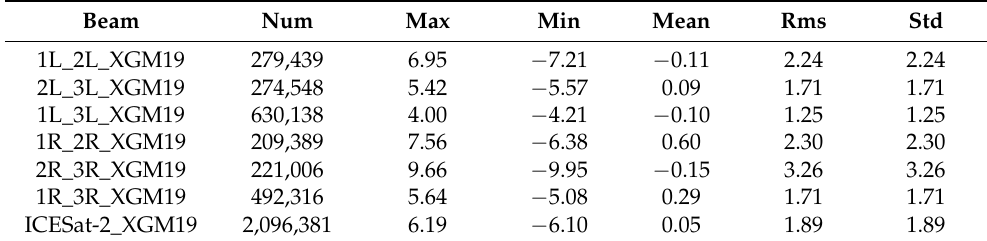
Table 12. Statistics of differences between the cross-beam DOVs and the XGM2019e_2159-DOV model (Unit: arc_sec).